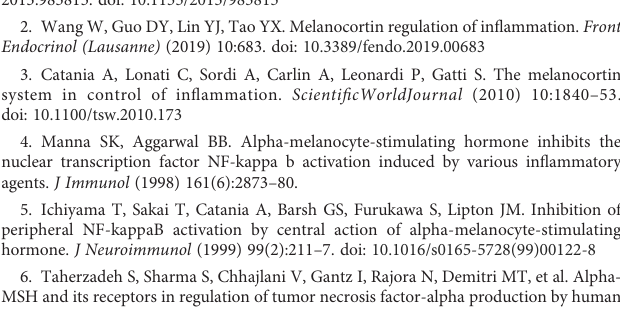
SUPPLEMENTARY FIGURE 1 Marker gene expression for each cell type of DSS colitis – induced rats, where dot size represents percentage of cells within a cluster with marker gene expression (percent expressed) and color encodes the average expression level across all the cells within a cluster (average expression). The plot is an integrated PL8177 50 µg, sham, and placebo Seurat object. Three samples from each group. DSS, dextran sulfate sodium; EE, enteroendocrine; EEP, enteroendocrine progenitor; SM, smooth